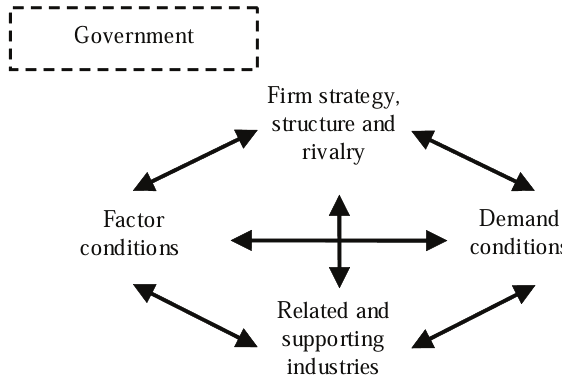
Fig. 2. Porter’s Diamond model for the Competitive Advantage of Nations (Porter 1998)